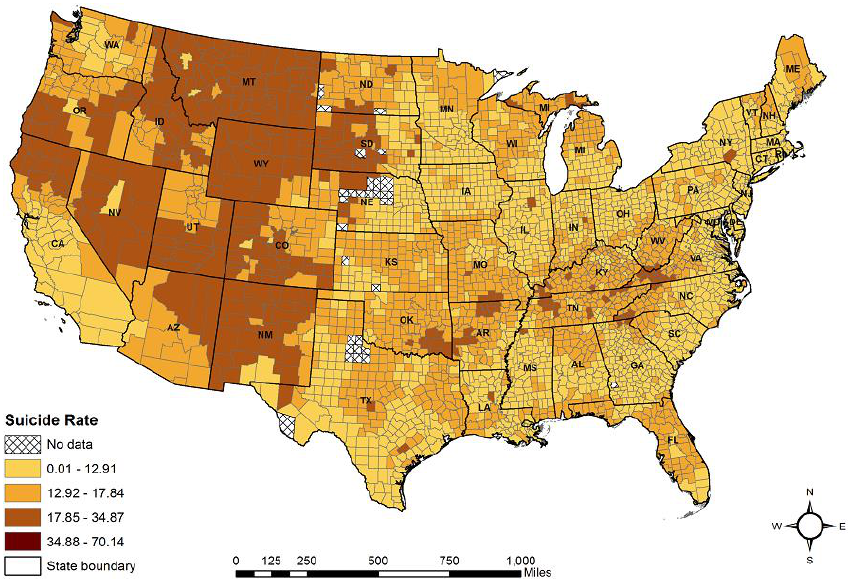
Figure 1. County-level average suicide rates in the 48 contiguous U.S. states between 2008 and 2014 (smoothed and age-adjusted).